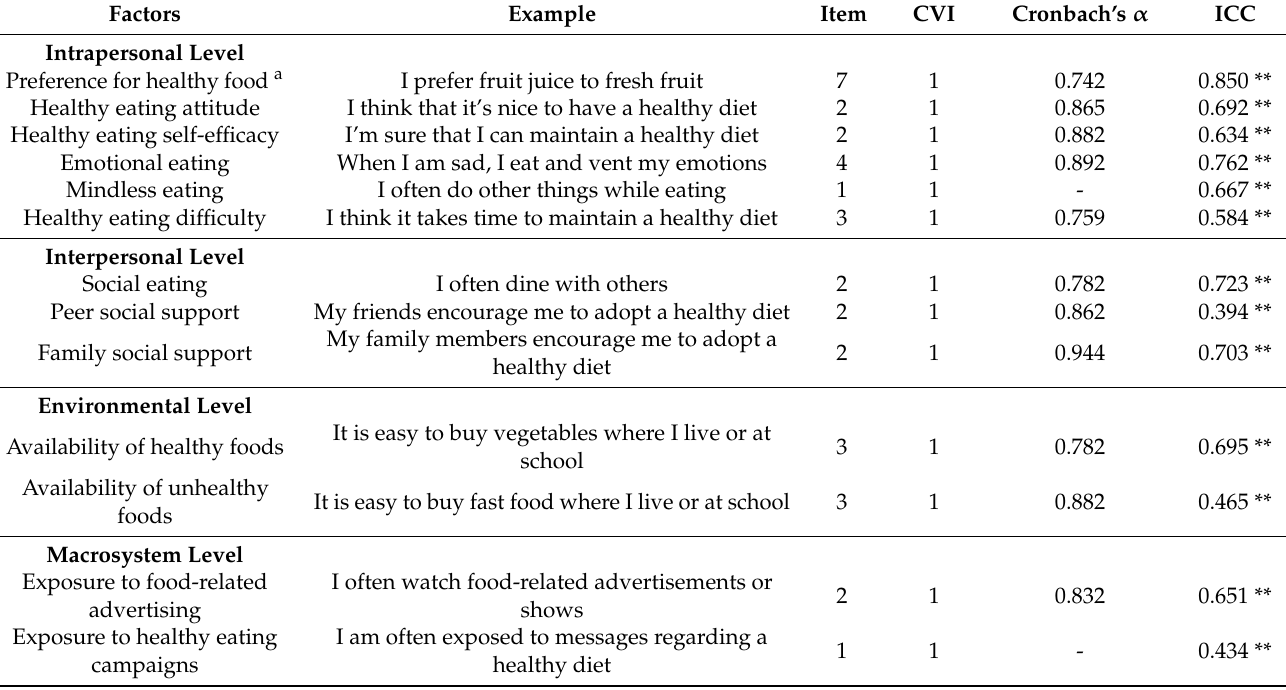
Table 1. Reliability and validity of the scale measuring factors influencing healthy eating behavior.